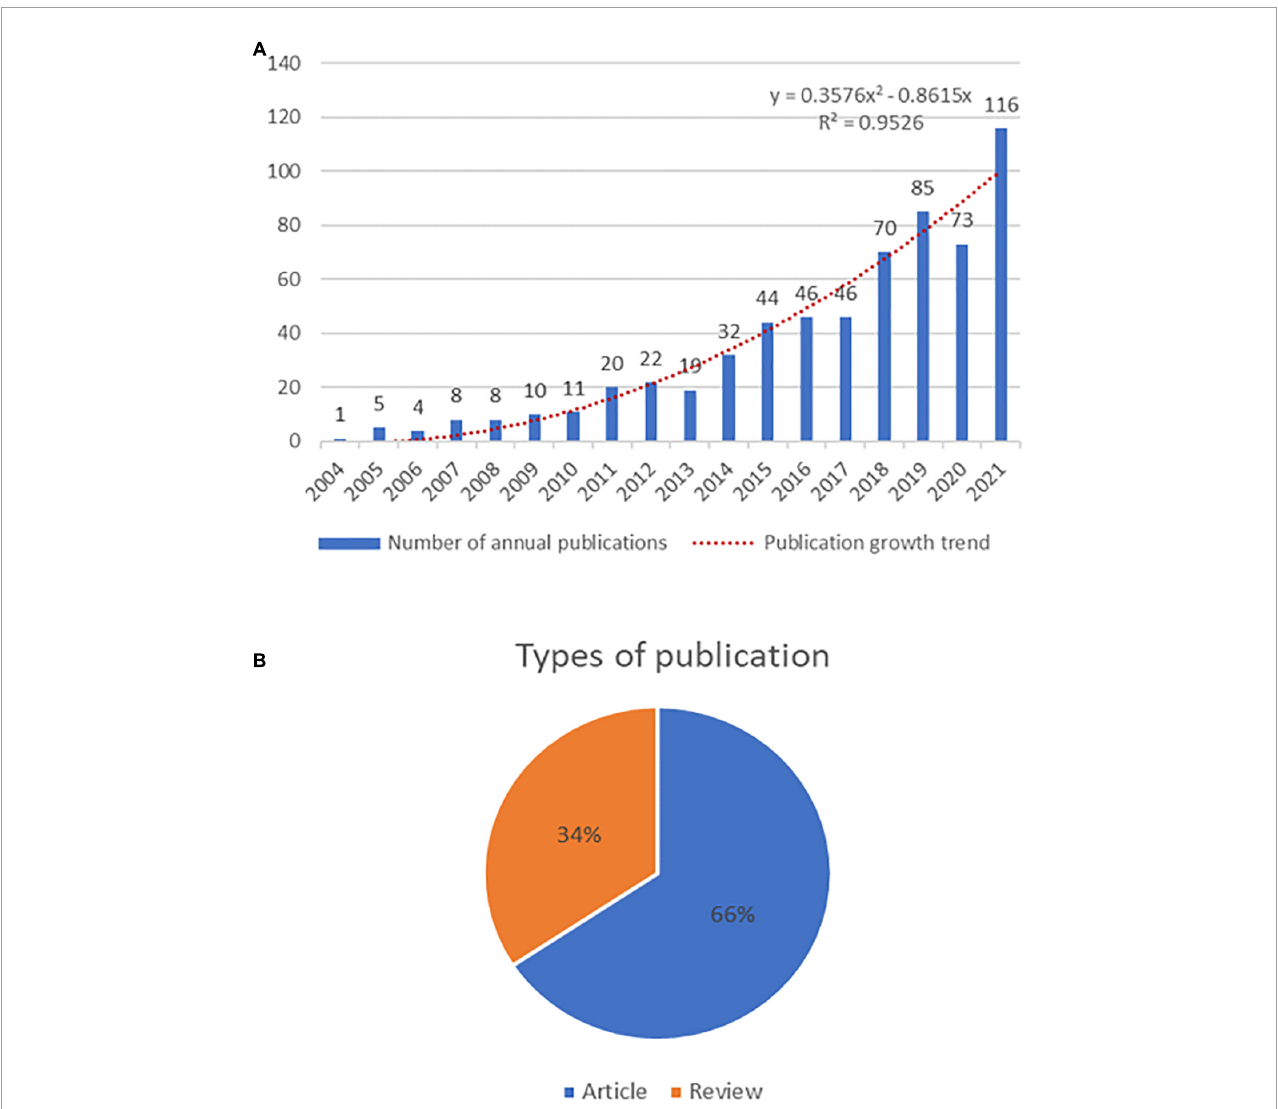
FIGURE1 (A) The combination chart of the number of annual publications. (B) Type of